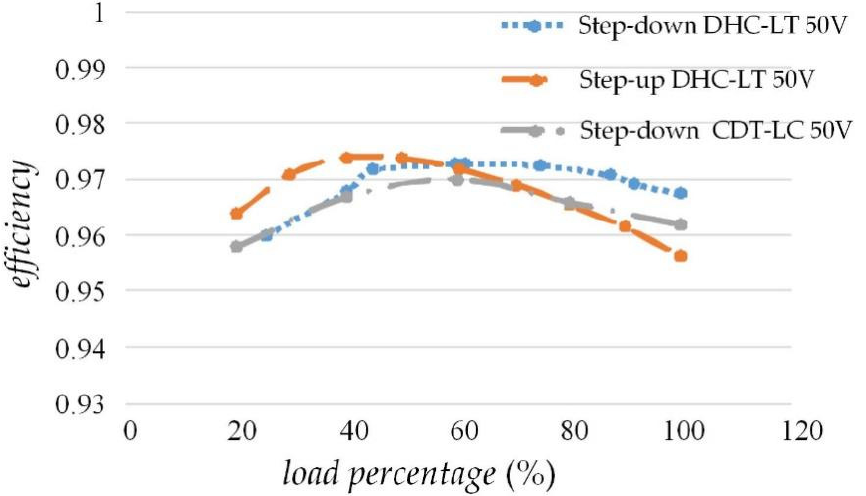
Figure 16. Efficiency curves of DHC-LT and CDT-LC.